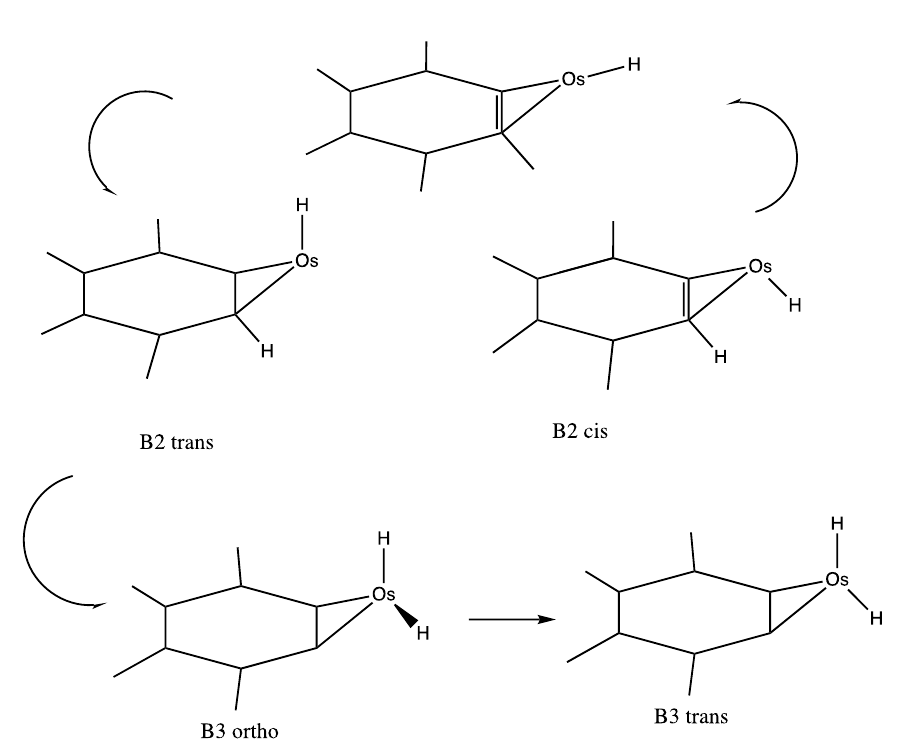
Figure 6. Landmarks for the second proton transfer to Os for the bicyclic scaffold (the Bicyclic Path B ) which passes to B3 ortho . The barrier to conversion to B3 trans is 0.254